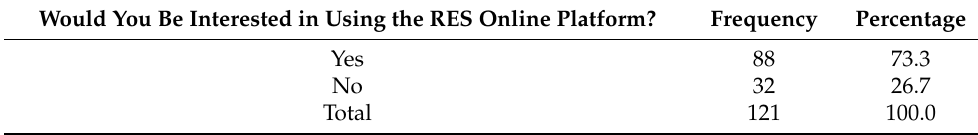
Table 8. Declarations of respondents of the CATI survey related to the use of the RES online platform. Would You Be Interested in Using the RES Online Platform?